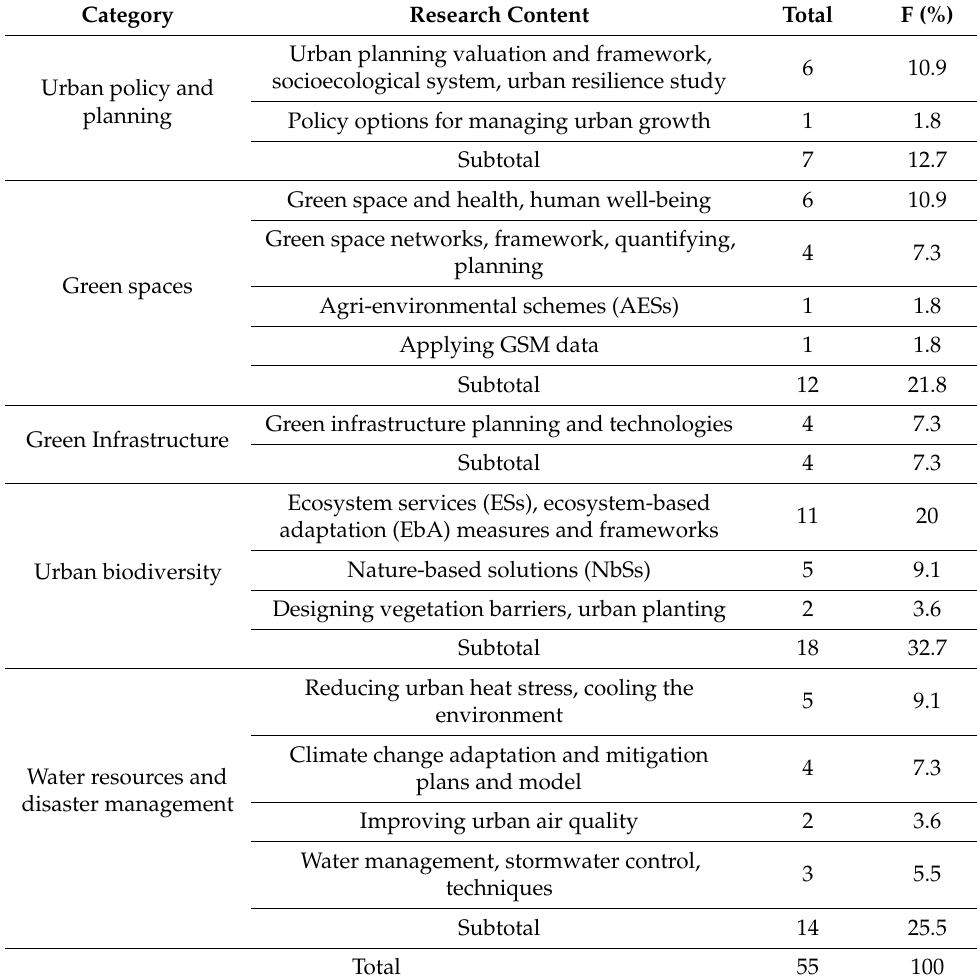
Table 8. International green infrastructure